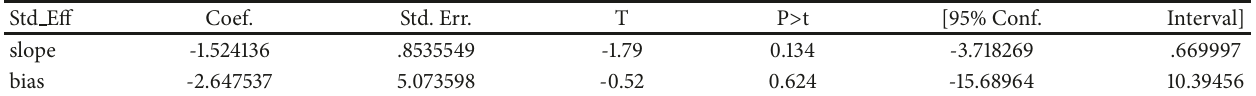
Table 3: Egger’s test.